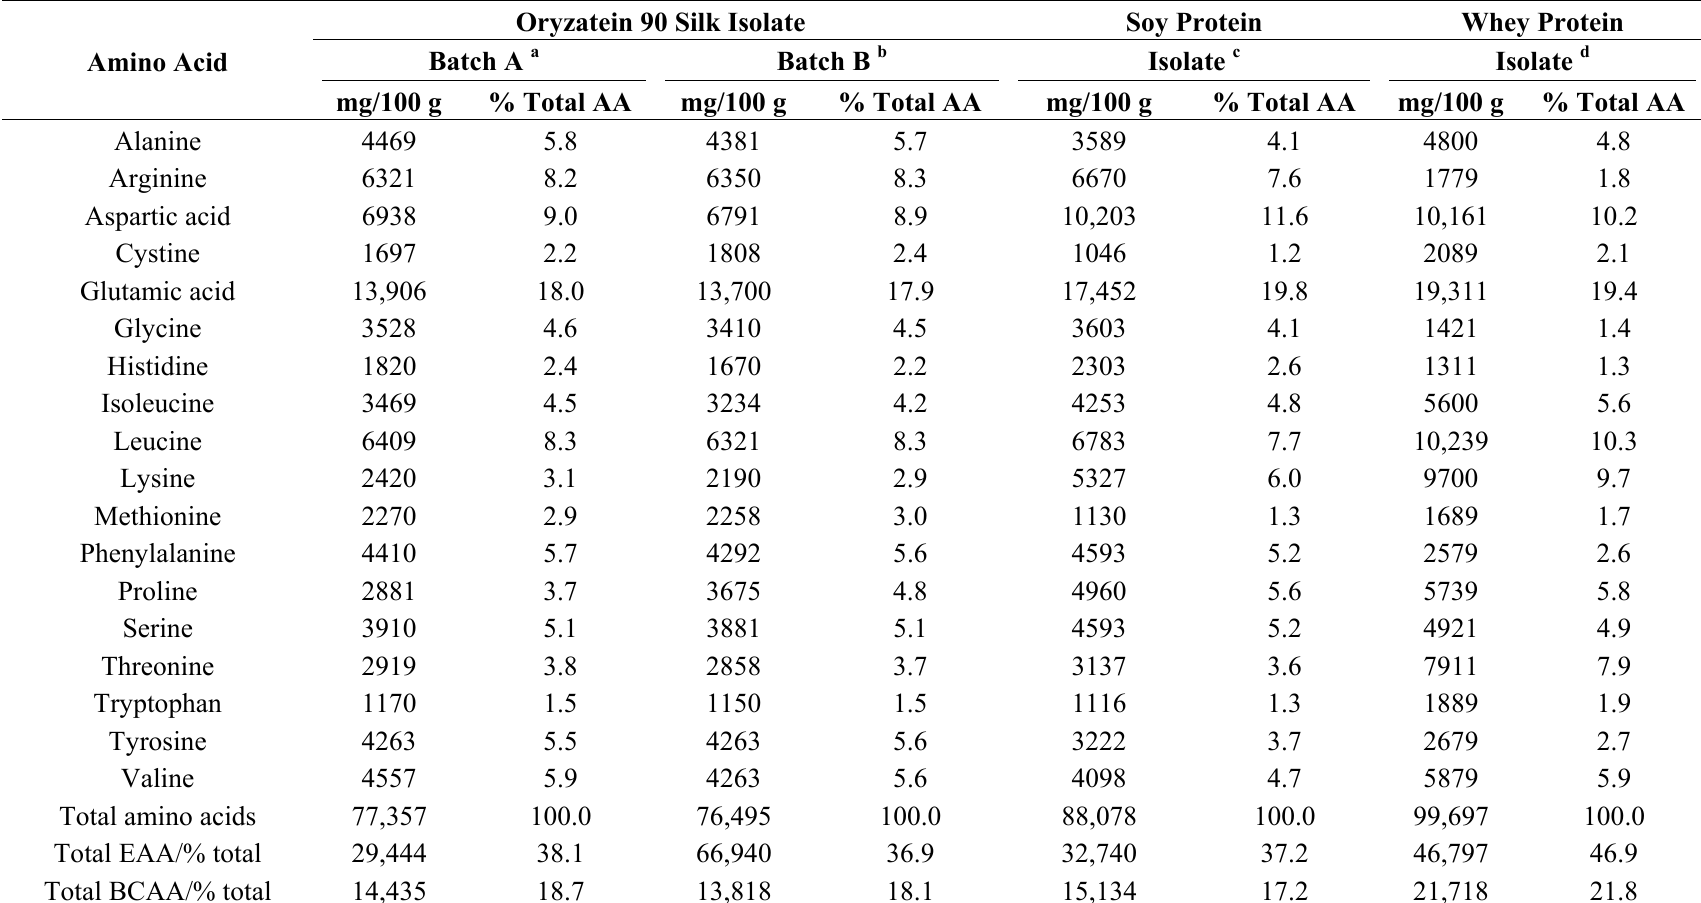
Table 2. Amino acid composition of Oryzatein brown rice protein isolate, whey protein isolate and soy protein isolate. Amino